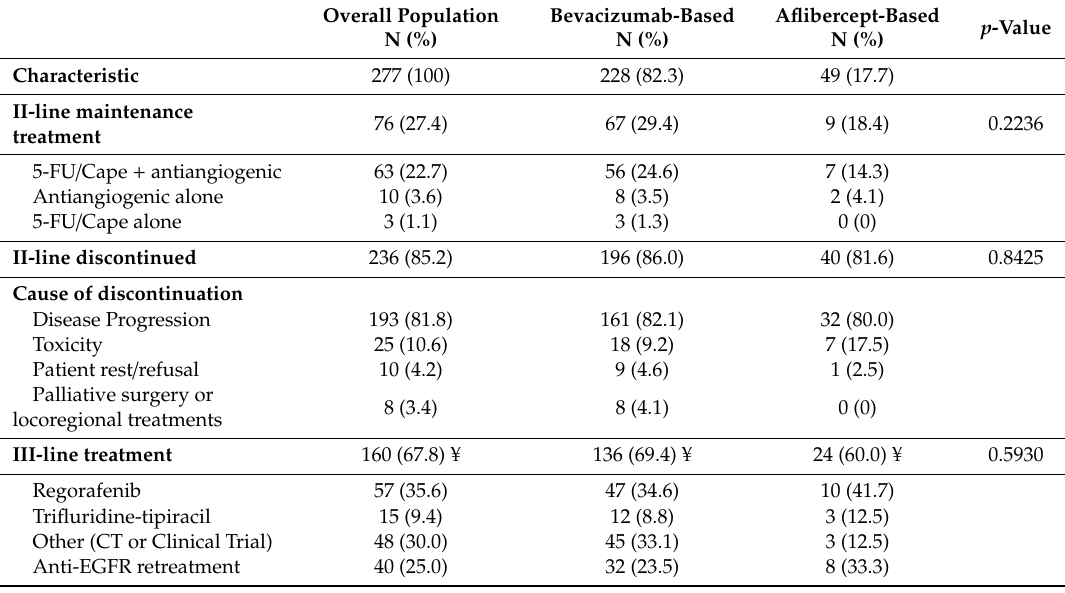
Figure 2. Incidence of G1/G2 ( A ) and G3/G4 ( B ) VEGF inhibitors class-specific adverse events according to the second-line regimen. AV: arteriovenous; GI: gastrointestinal. Second- and third-line treatment characteristics in overall, Bevacizumab-based and Aflibercept-based